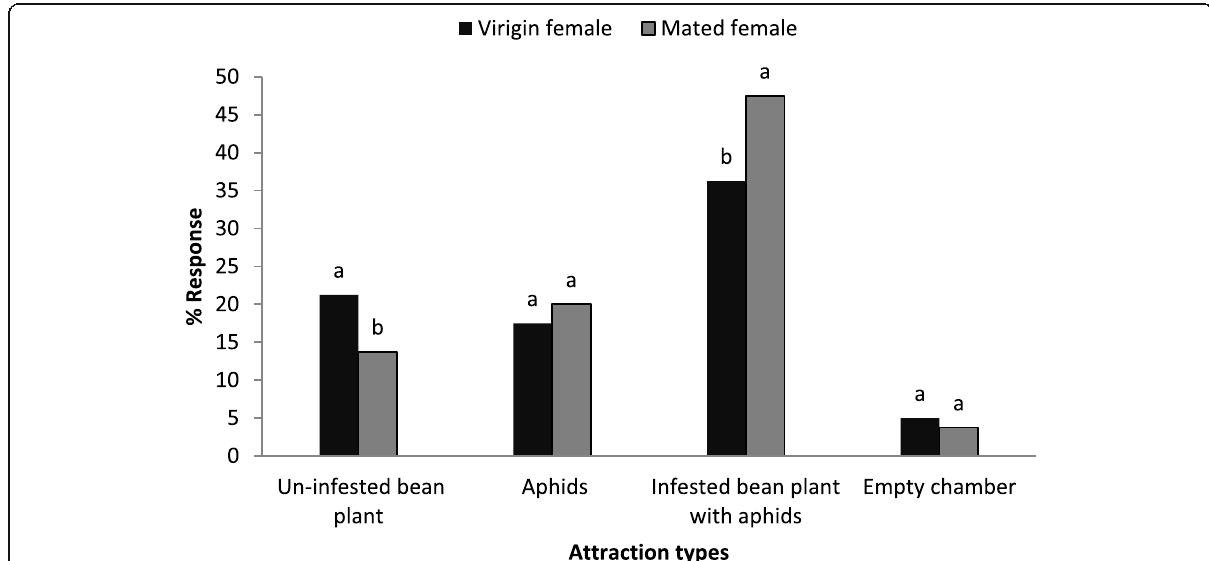
Fig. 2 Percentage of response of the virgin and mated females of Coccinella undecimpunctata to different odor sources, tested in a 4-arm olfactometer (single individual